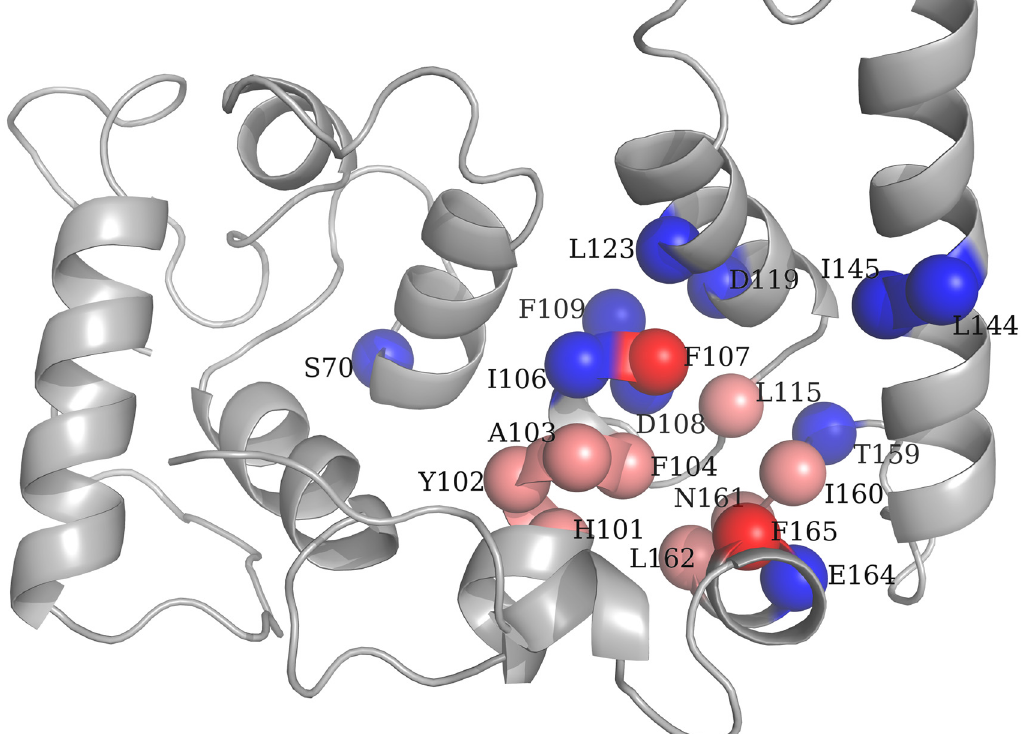
Fig 9. Ligand-free structure of CIB1. Residues are colored as follows: Key position residues (pink), residues identified by UniProt[75] whose mutations affect the affinity for substrate and catalytic activity (blue), and key position residues identified also by Uniprot (red).